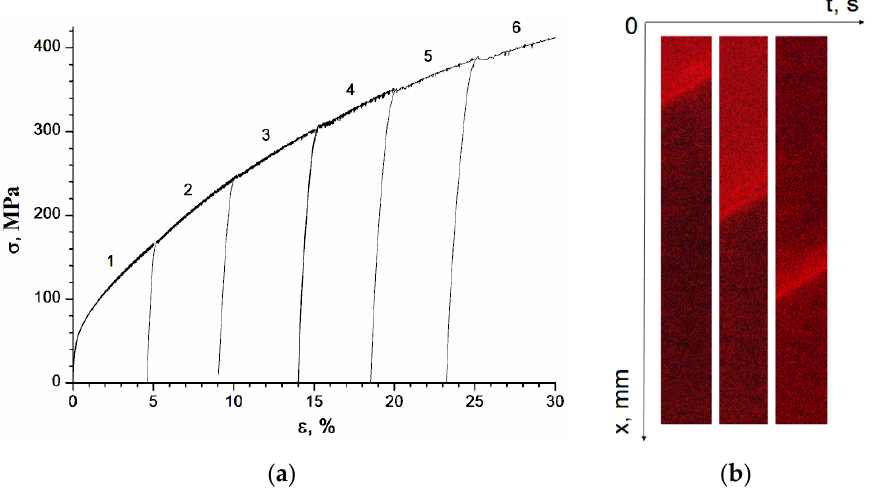
Figure 1 . Stress–strain curve of Ni samples with a strain rate of 6.67 × 10 − 5 s − 1 in the load–unload mode (Sections 1–6 with an increase in total deformation of 5%) used for determination of the damage parameter ( a ) and visualization of strain localization patterns in the form of PLC bands using DSC method ( b ).